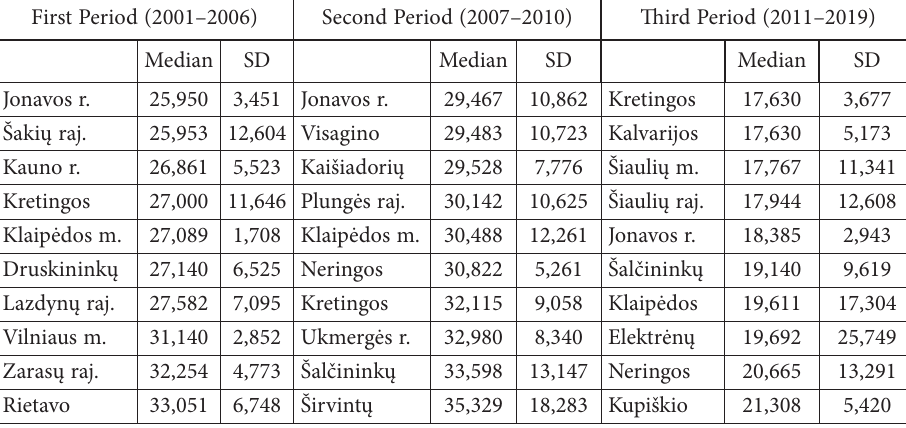
Table 4. Municipalities with the 10 largest shadow economies First Period